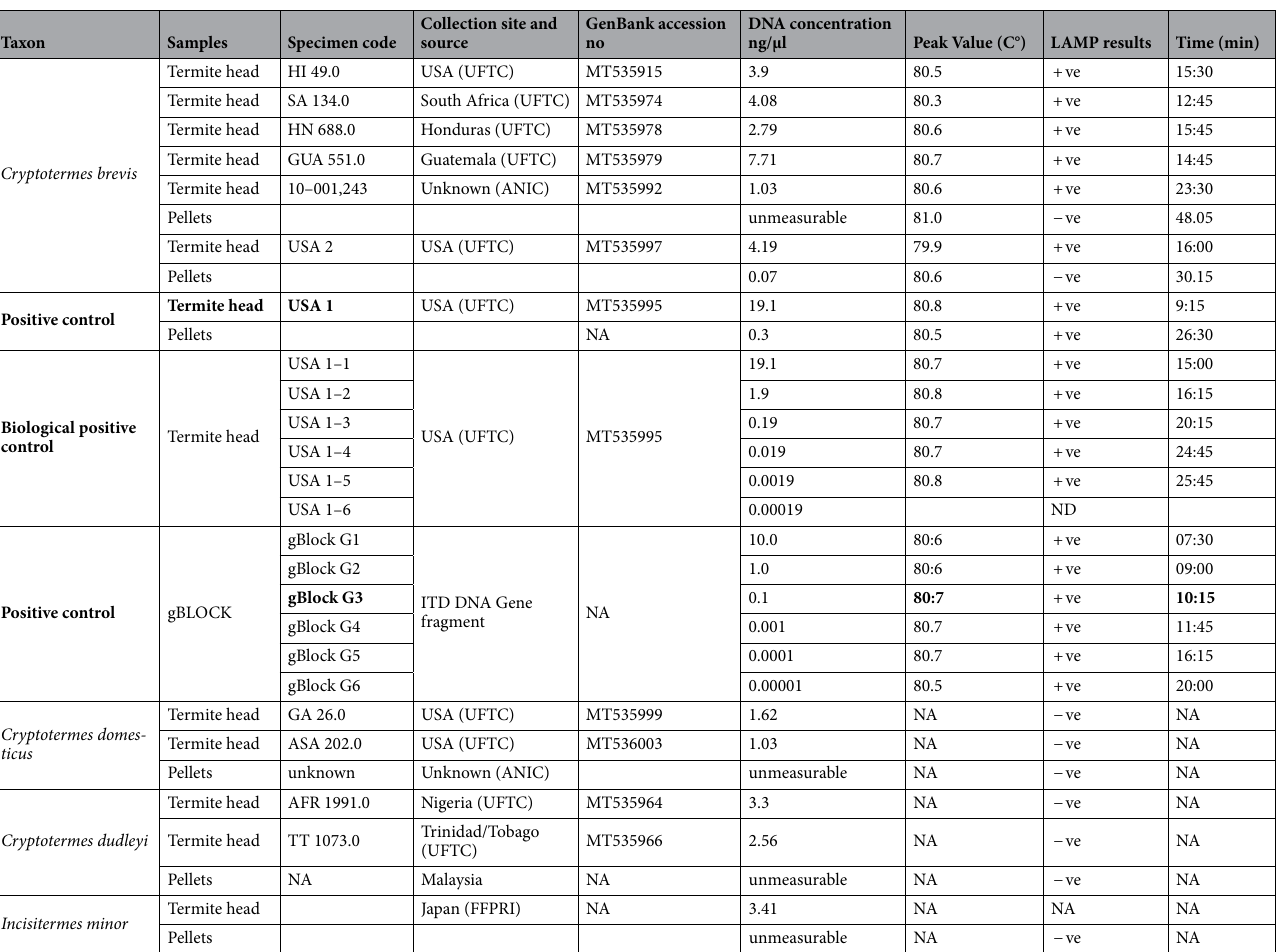
Table 1. Designation of species, insect collection, and specificity test result of specimens used in LAMP test: ANIC Australian National Insect Collection, Commonwealth Scientific and Industrial Research Organisation, Canberra, Australia, UFTC University of Florida Termite Collection, The University of Florida , Institute of Food and Agricultural Sciences, USA, FFPRI Forestry and Forest Products Research Institute, Japan. + ve positive, − ve negative, NA Not available, ND Not detected. Positive controls are in